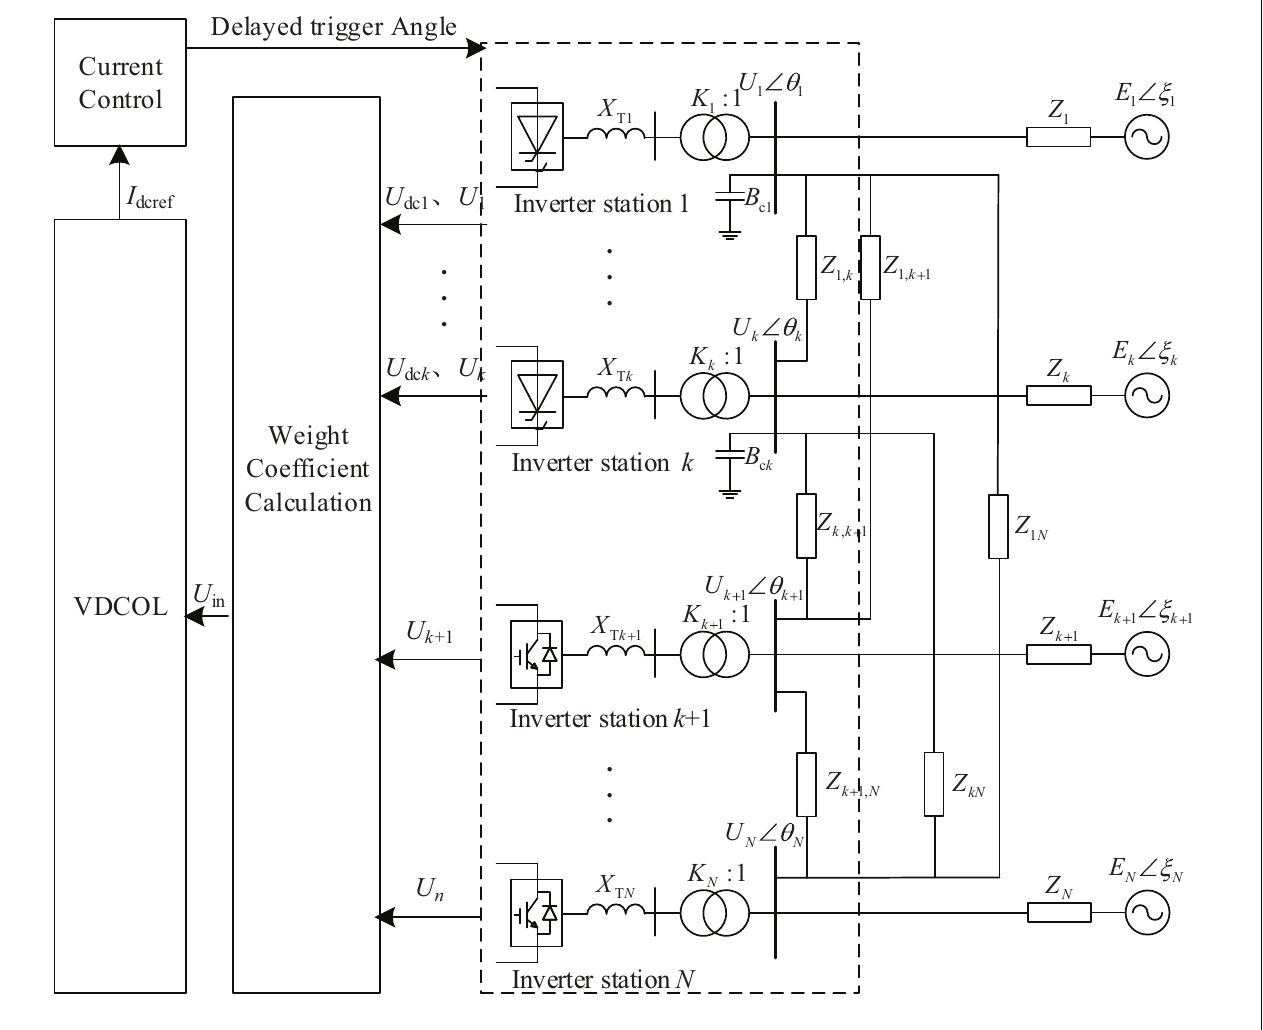
FIGURE 1 | Hybrid multi-infeed DC transmission system model.